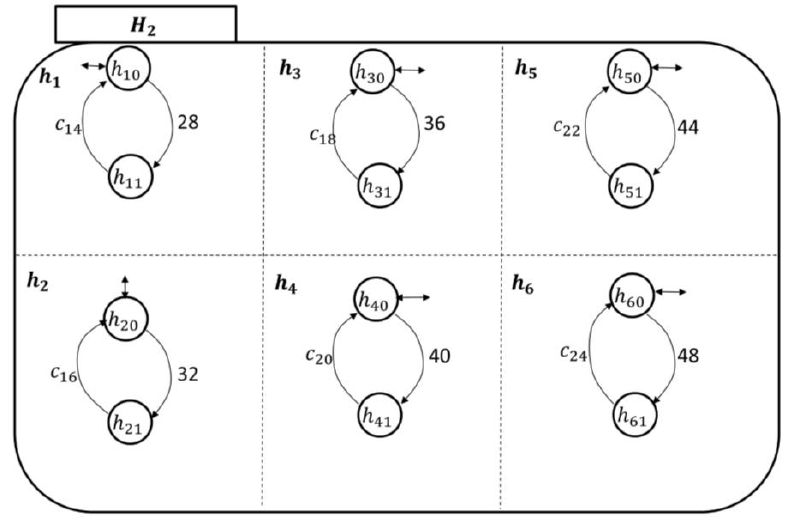
Figure 17. The hospitalist automaton (𝑯 𝟐 ) transitional model.